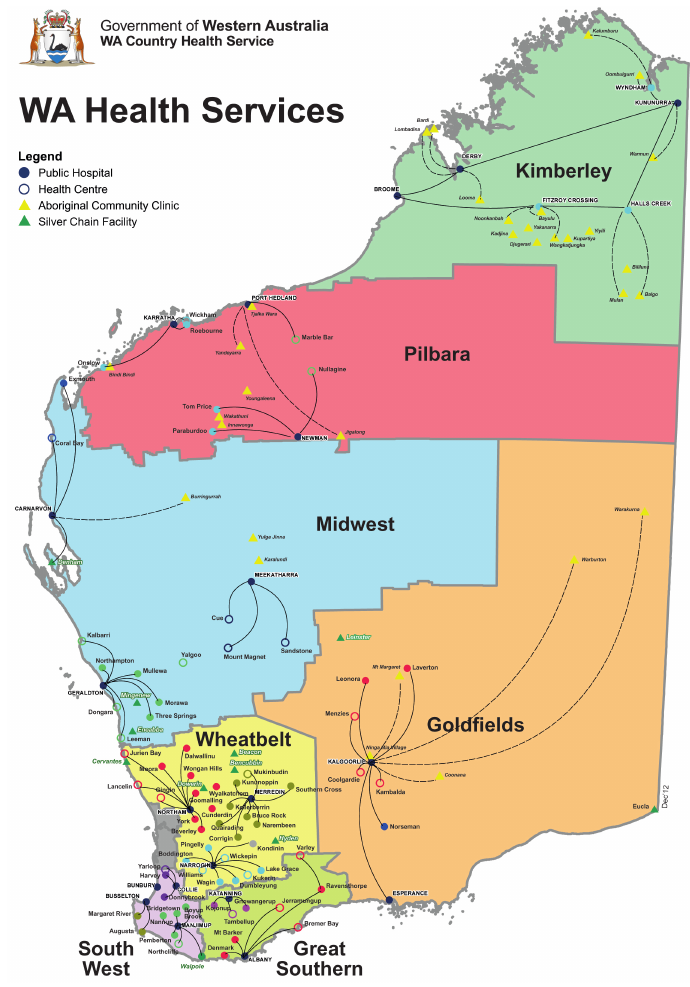
Figure 1. Western Australia health regions